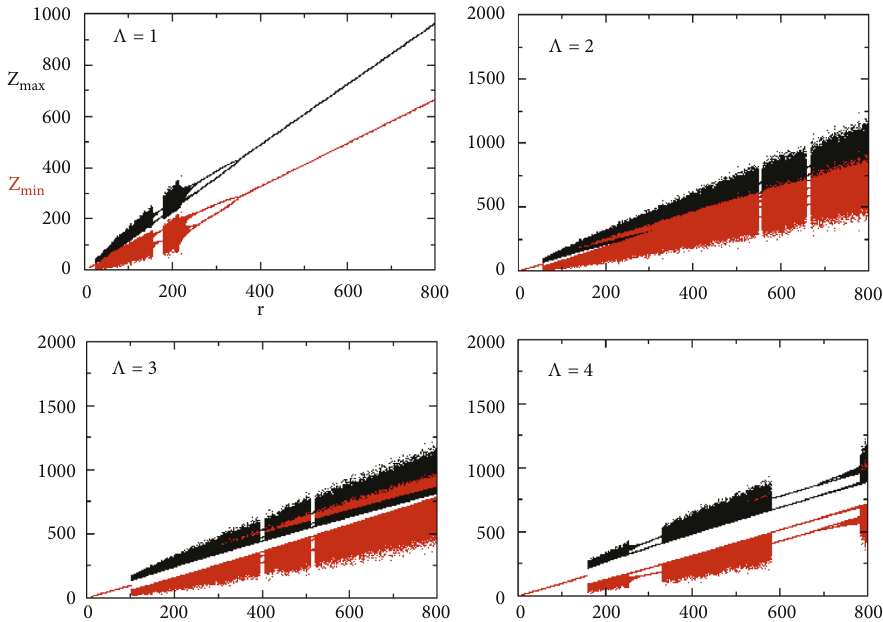
Figure 2: Diagrams of bifurcations of Z as a function of r representing the maxima and minima of the posttransient solution of Z ( τ ) showing the effect of the viscosity ratio Λ on the chaos of the system for Da � 1, s � 0, and Ta � 0 with P � 10, L � M � √ k � π / 2 , ε � 1, and σ � − 1/3 .